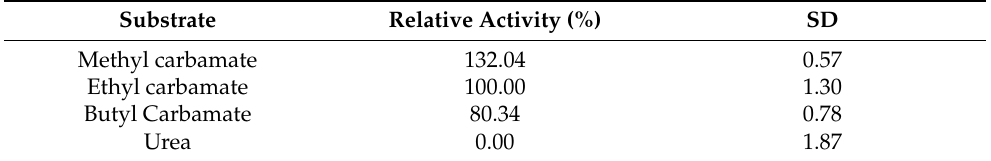
Table 2. Substrate specificity of